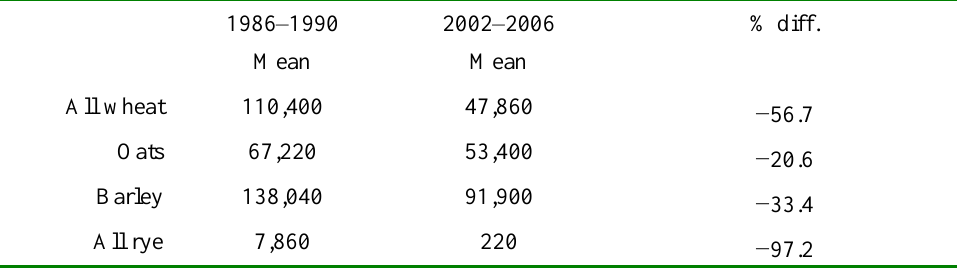
Table 6. Summary Statistics, Changes in BC Grain Production,